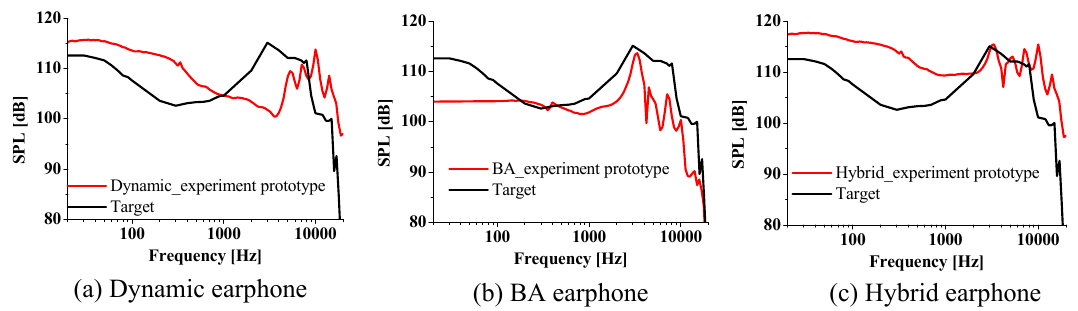
Figure 12. Earphone sound pressure level (SPL) comparison between experiment and simulation.